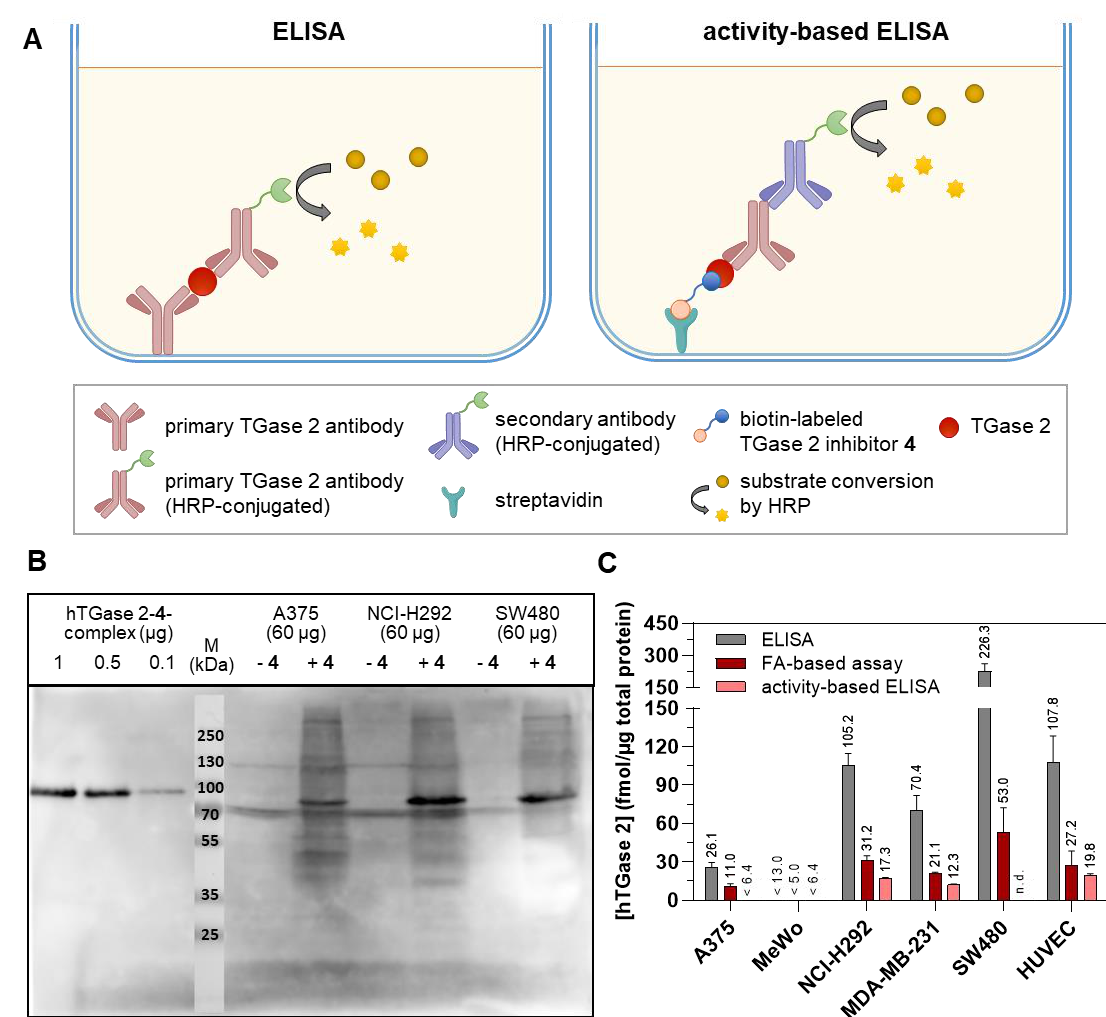
Figure 6. Overview of the applied ELISA methods and hTGase 2 concentrations obtained with these methods. ( A ) Left: Principle of the applied commercially available two-site sandwich ELISA (Zedi Xclusive Tissue Transglutaminase EIA, E018) from Zedira ® to detect hTGase 2. Right: Principle of the developed activity-based ELISA using biotinylated inhibitor 4 and streptavidin-coated well plates to detect active hTGase 2. The procedures for both methods are described in Sections 4.5 and 4.7, respectively. ( B ) Visualization of recombinant hTGase 2 and hTGase 2 in cell lysates with inhibitor 4 (20 µ M) after separation of the reaction mixtures with SDS-PAGE and detection by immunoblotting with HRP-streptavidin and luminescence readout. Thermo Scientific™ PageRuler™ Plus Prestained Protein Ladder was acquired with white light illumination and automatically merged to the chemilu- minescent image (imager Celvin S). ( C ) Side-by-side comparison of concentration data for hTGase 2 (in fmol/ µ g total protein) in cell lysates from different cell lines determined with the two-site sandwich ELISA, the FA-based assay and the activity-based ELISA. n.d. denotes not